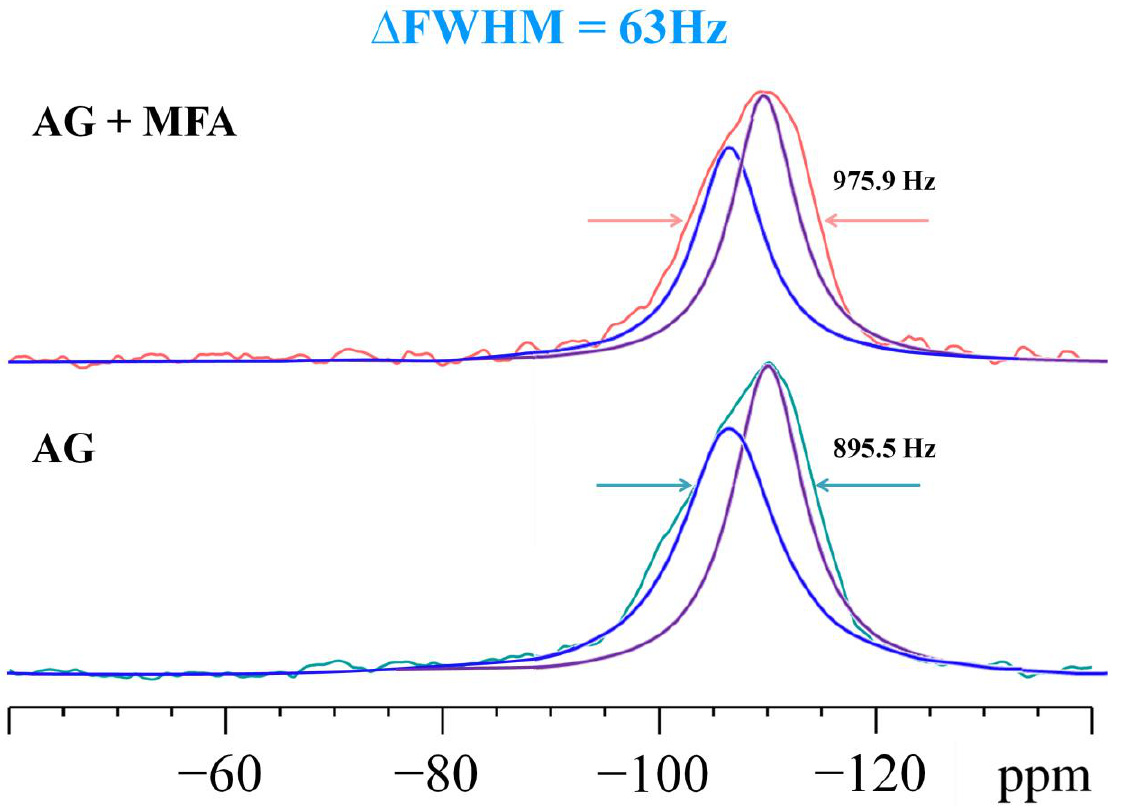
Figure 3. The 29 Si MAS NMR spectra of pure aerogel (green line) and aerogel with MFA (pink line) and results of pseudo-Voigt profile approximation for deconvolution of signal lines, including Q 3 (blue lines) and Q 4 (purple lines) tetrahedral units. ∆ FWHM — difference between the widths at half-height signals for doped and pure aerogel.